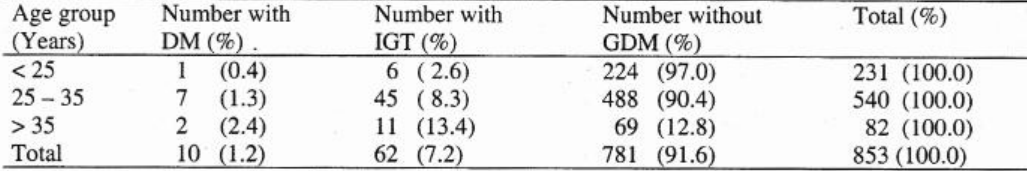
Table 2.Age specific diabetes mellitus and impaired glucose tolerance in the study sample ‘Age